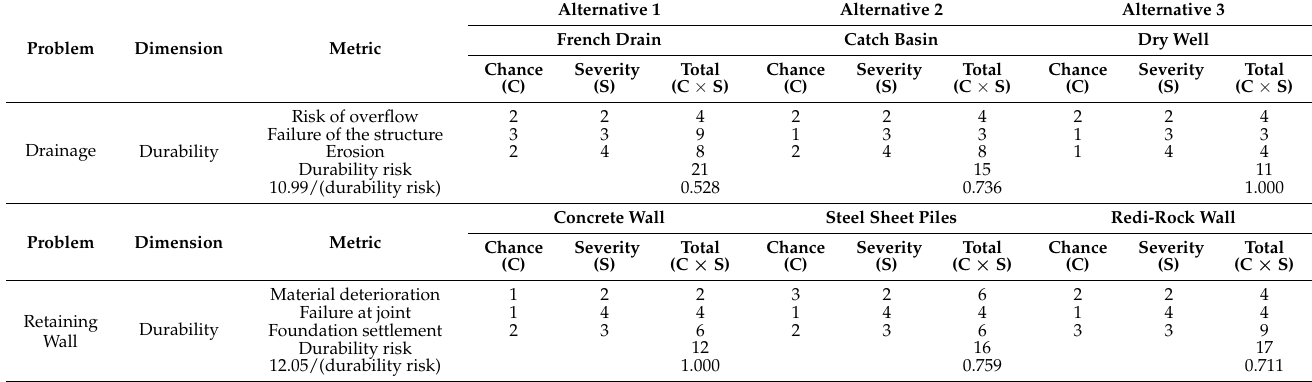
Table 10. The level of noise and vibration of French drain.